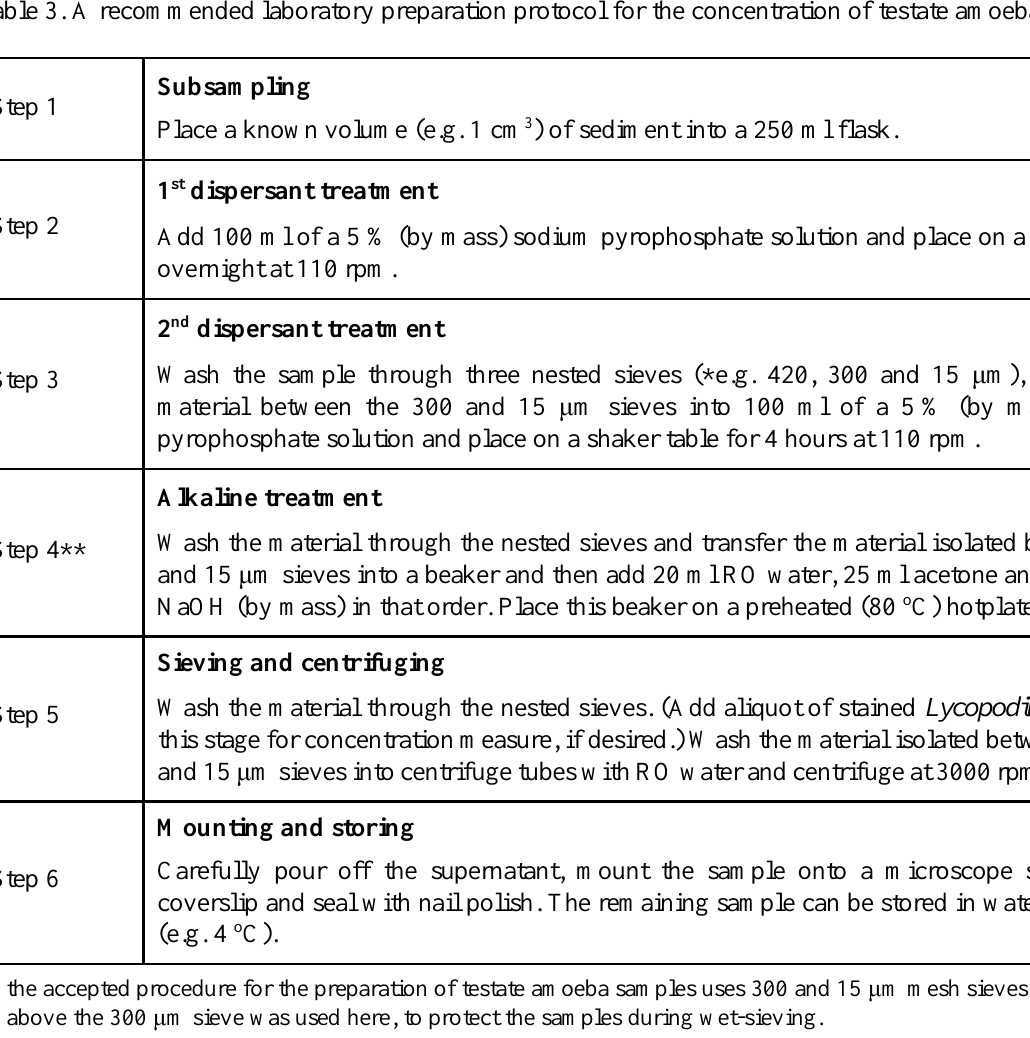
Table 3. A recommended laboratory preparation protocol for the concentration of testate